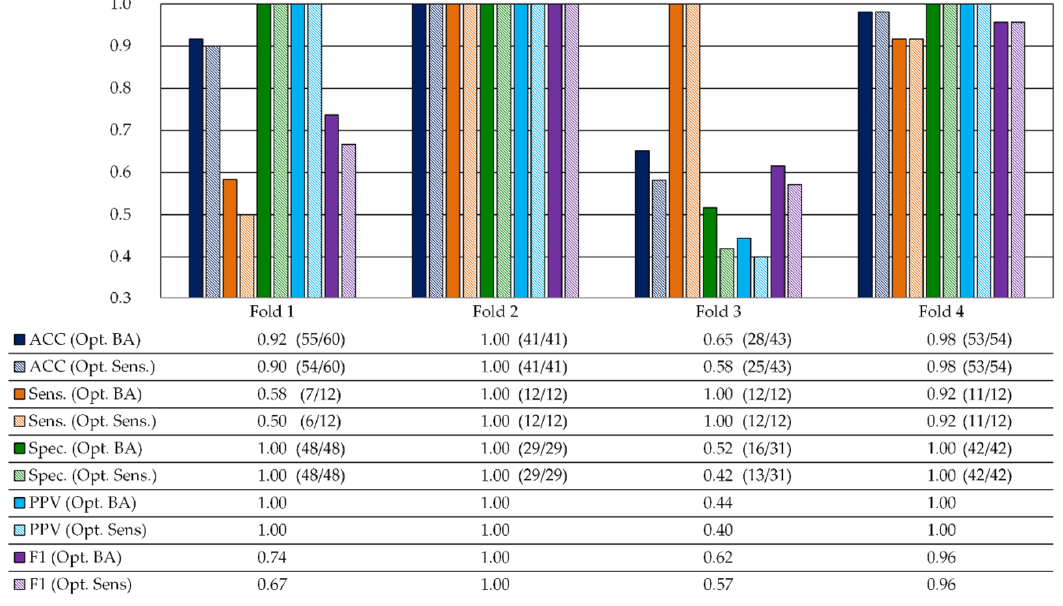
(BA and Sensitivity) for the hyperparameter optimization of the SVM Linear kernel.